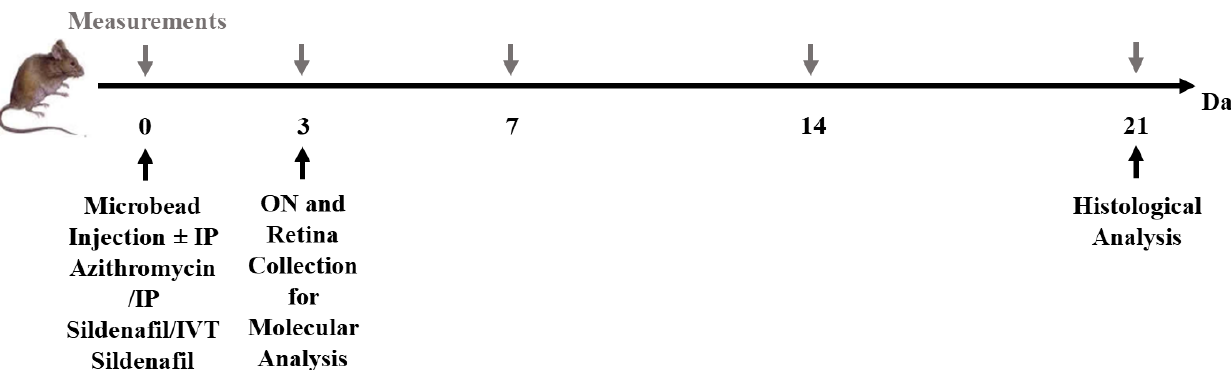
Figure 11. Study design. IOP was measured at baseline, followed by injection of microbeads and administration of treatment according to the treatment group. The IOP was then measured periodically on days 3, 7, 14, and 21. On day 3, mice allocated for molecular analysis were euthanized for retina and optic nerve collection. On day 21, the remaining mice were euthanized for histological analysis. IOP, intraocular pressure, IP, intraperitoneal; IVT, intravitreal; ON, optic